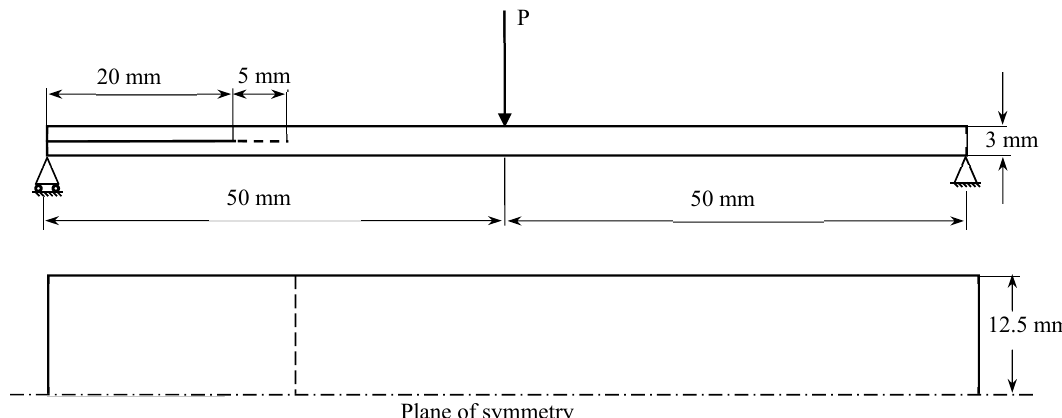
Figure 3. Effective dimensions of the specimen in Mode II tests.